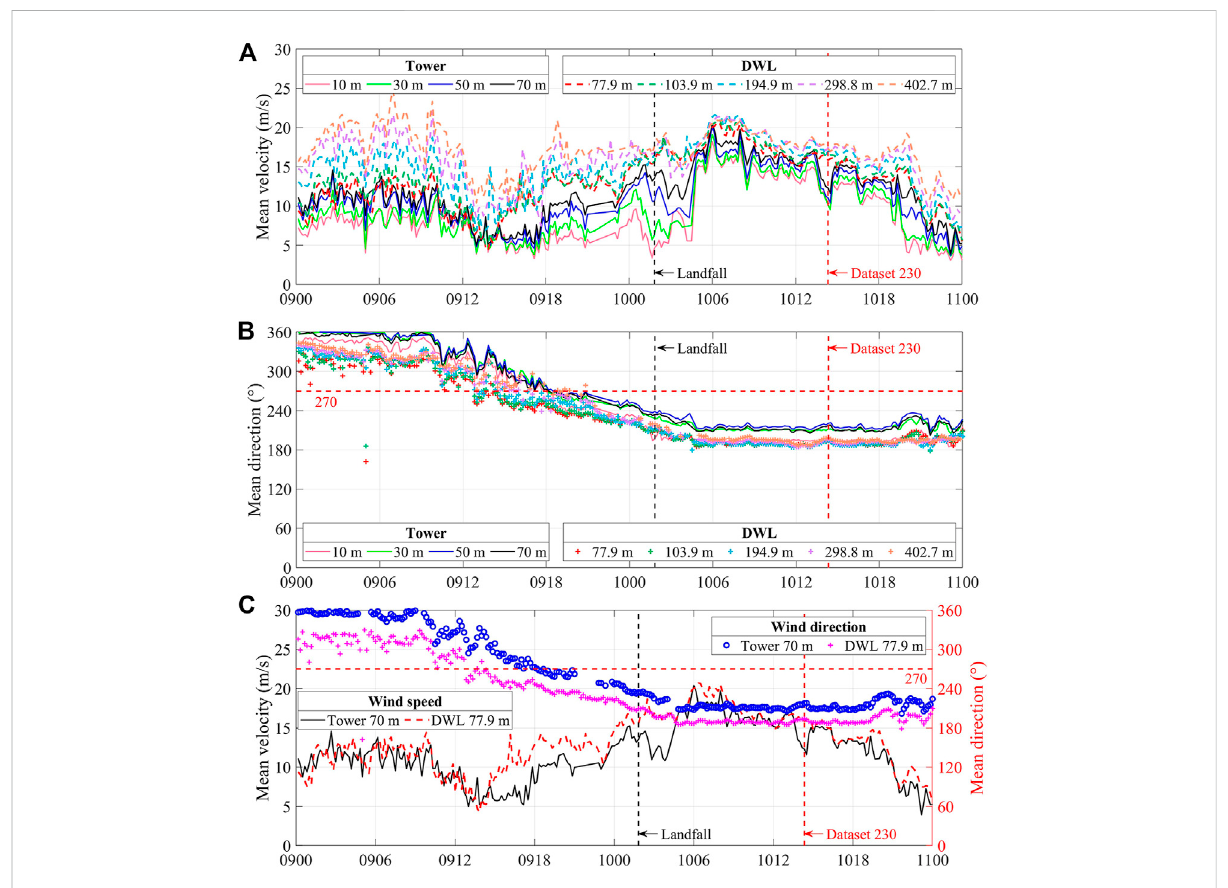
between these two measurements. Since the tower base is around 10 m higher than that of the DWL, it can be considered that the two observations are performed at the same height. From Figure 7C, general trend and magnitude of wind speeds measured by both instruments are almost the same except for the time period before and after the landing of typhoon, during which wind tower measured wind speed is lower. At that time, prevailing winds start to blow from the west and southwest, and upstream terrain conditions of the wind tower is hilly with an altitude of more than 100 m, while it is residential areas and gentle slopes for the DWL with an altitude of about 40 m. Since hilly terrain with higher altitude exerts stronger shielding effects on the wind fi eld, the associated downstream wind speed is much lower. Therefore, the wind speed measured by the wind tower is lower. Regarding to the wind direction, although the trends of wind tower and DWL data are consistent, the wind direction monitored by the DWL shifts around 30 ° counterclockwise due to local